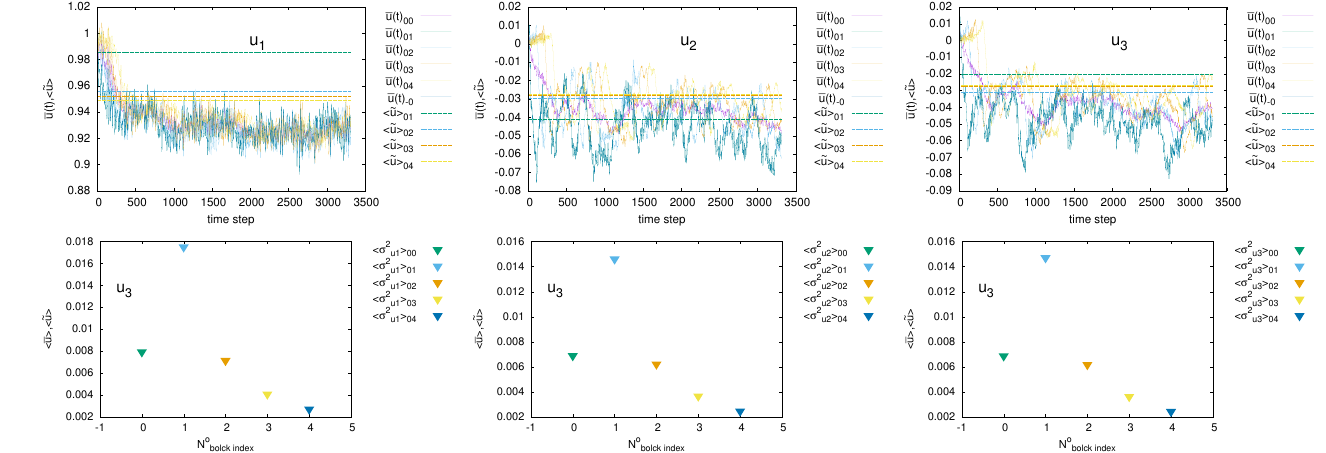
Figure 14. Standard deviation of velocity components from time-bin averaging at sub-block probes and from spatial averaging over sub-blocks. Top: u ( t ) , < ˜ u > ; bottom: σ 2 ( u ( t )) , < σ 2 ( ˜ u ) > . Left to right: velocity components u 1 , u 2 , u 3 .